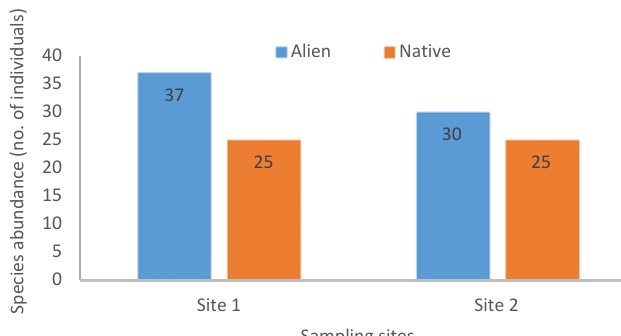
Fig. 2. Number of alien and native species found in S1 and S2 of Mt. Manunggal, Cebu Island,